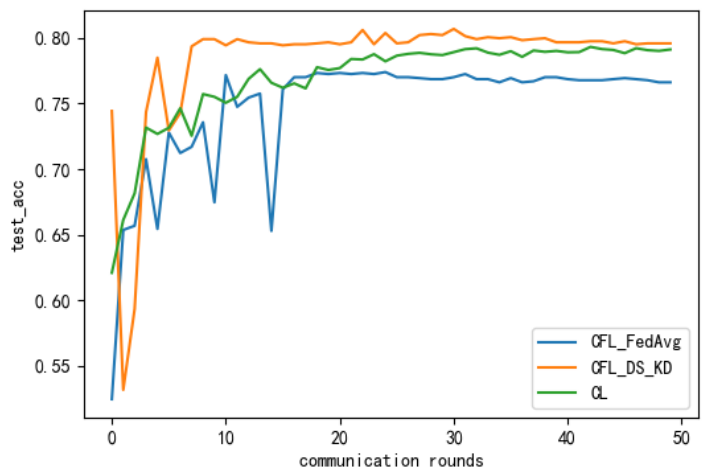
Figure 7. The accuracy of the different methods on the testing set after different amounts of commu- nication rounds.